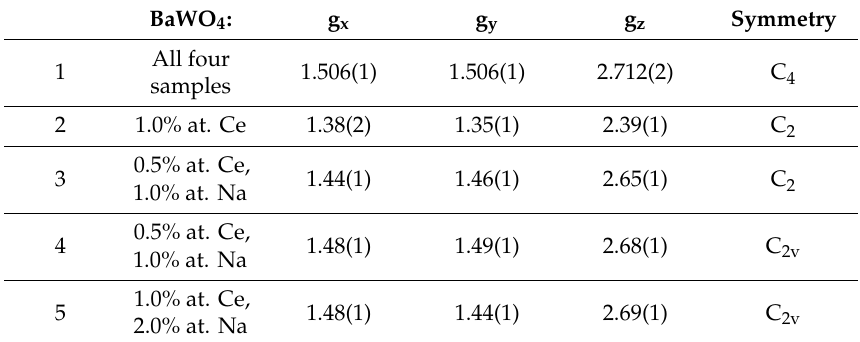
Table 1. Hamiltonian parameters of Ce 3 + ions, g-factors in the BaWO 4 crystal for selected centers, data from [8,9].